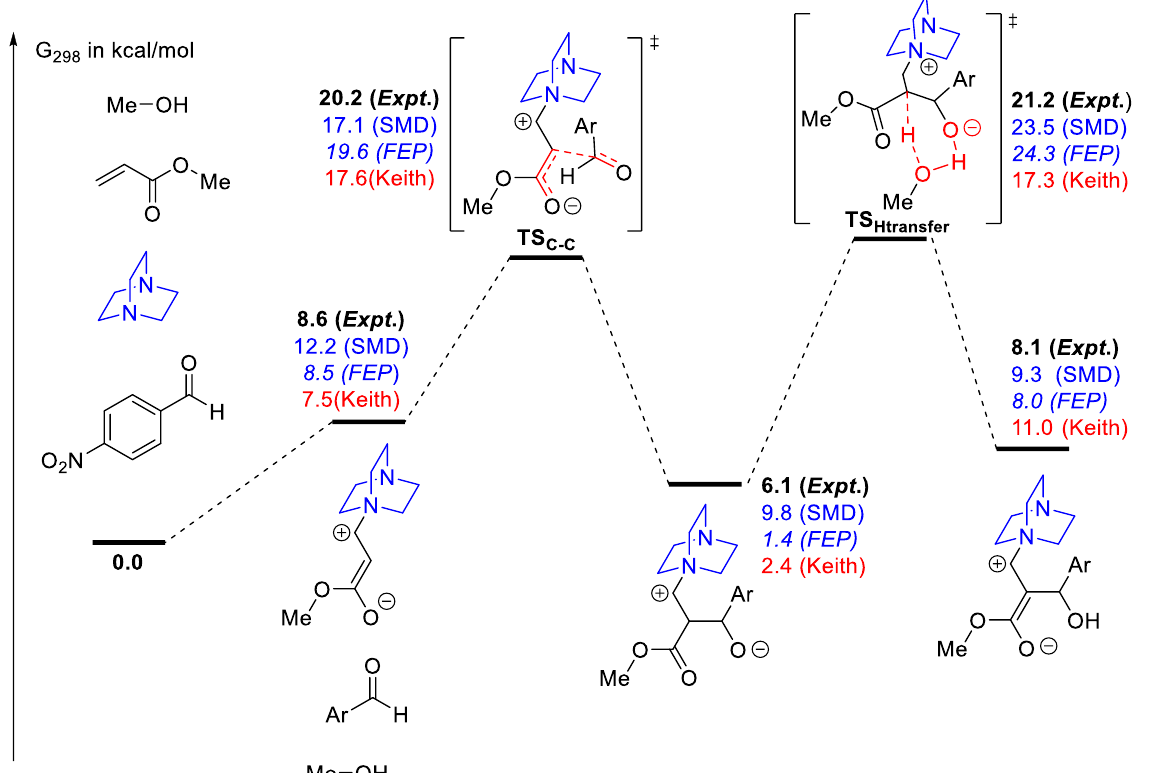
Figure 18. Partial free energy profile of MBH reaction. Experimental values are obtained from the work of Plata and Singleton [83]. Blue calculated values are from the work of Sunoj and co-workers [87] at DLPNO-CCSD(T)/CBS/B3LYP-D3/6-31+G(d,p) with solvation via SMD or FEP as indicated in parentheses. Red calculated values are from the work of Basdogan and Keith at DLPNO-CCSD(T)/def2-TZVP/BP86-D3/def2-SVP [160]. Explicit solvent molecules are not shown.